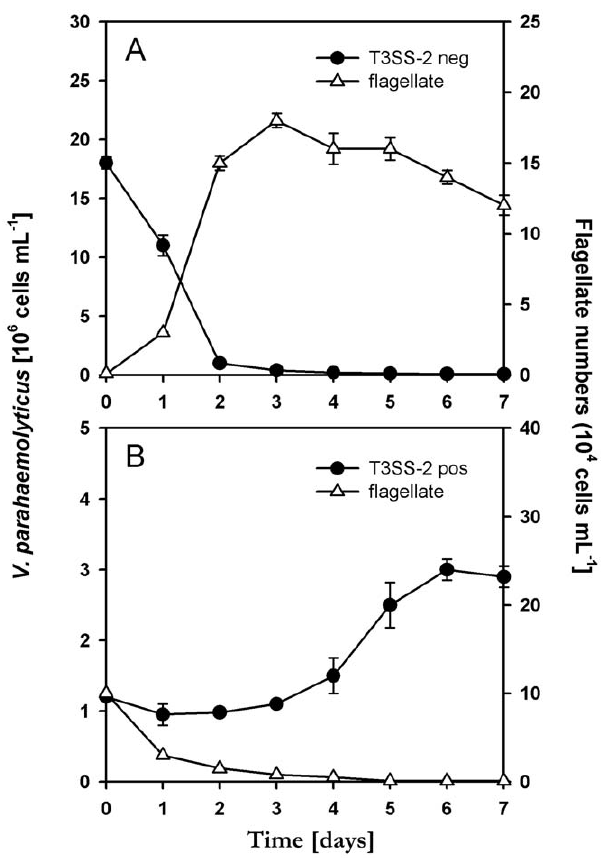
Figure 2. Prey-parasite lifestyle switch of V.parahaemolyticus as mediated by the accessory type III secretion system. Cell suspensions of the T3SS-2 deficient mutant POR3 (A) and the T3SS-2 positive wild type RIMD2210633 (B) were exposed to the flagellate C. roenbergensis . Flagellate numbers include only structurally intact cells and are given as means 6 standard deviation (n=4).